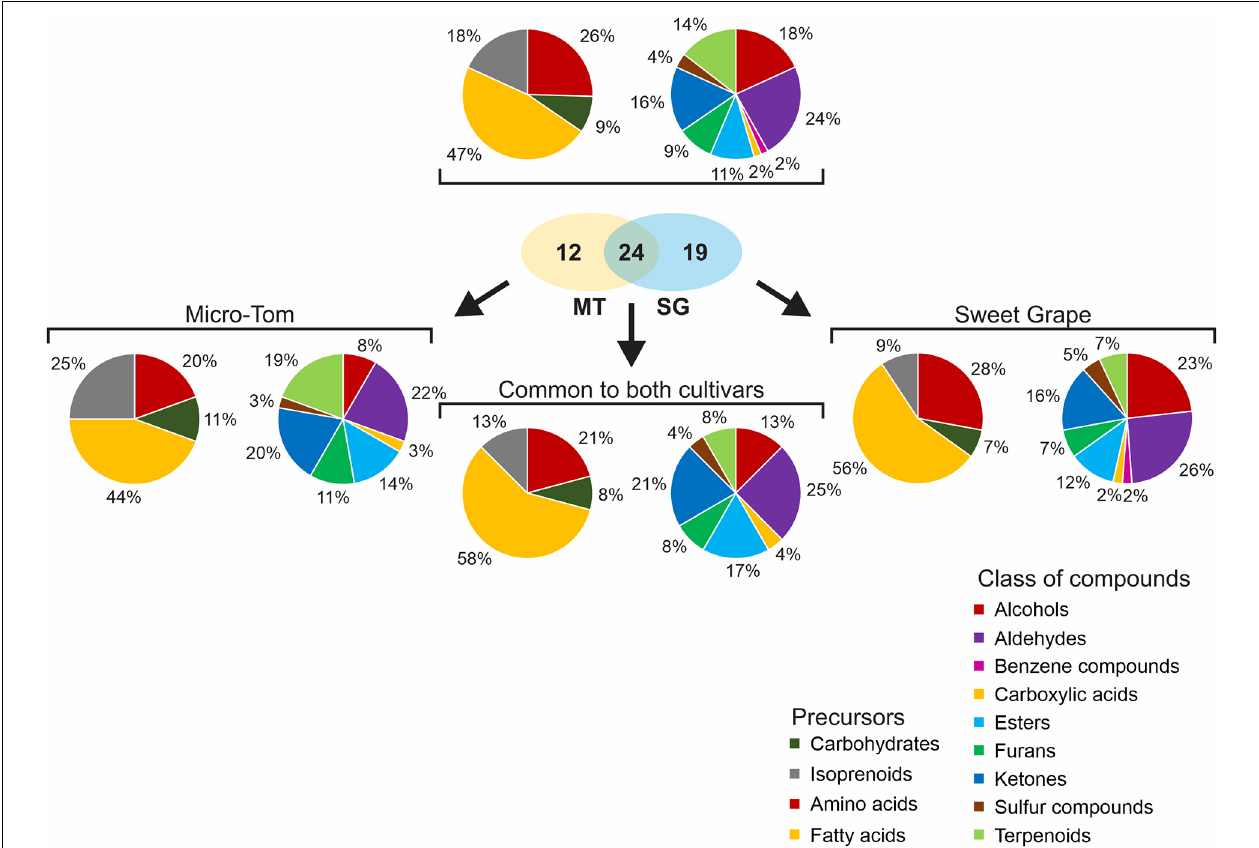
FIGURE 2 | Relative composition of volatile organic compound (VOC) profiles of tomato ( S. lycopersicum L.) fruits cv. Micro-Tom and Sweet Grape, as well as the “global” and the “common” VOC profiles. Left pie charts show the relative composition according to VOC precursors while right pie charts show the relative composition according to their compounds